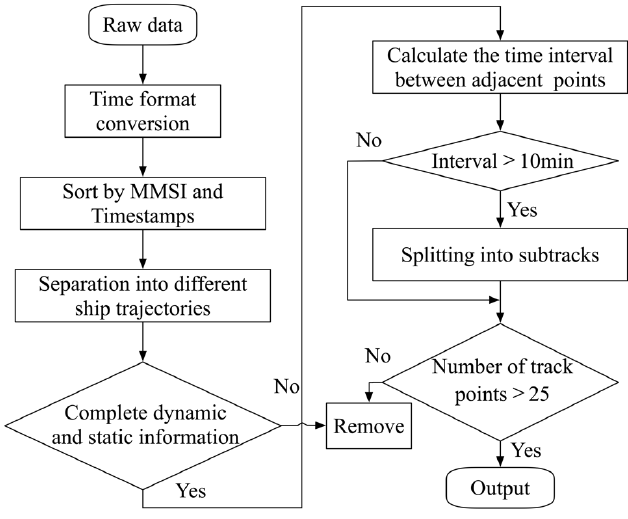
Figure 1. Trajectory integrity processing steps.